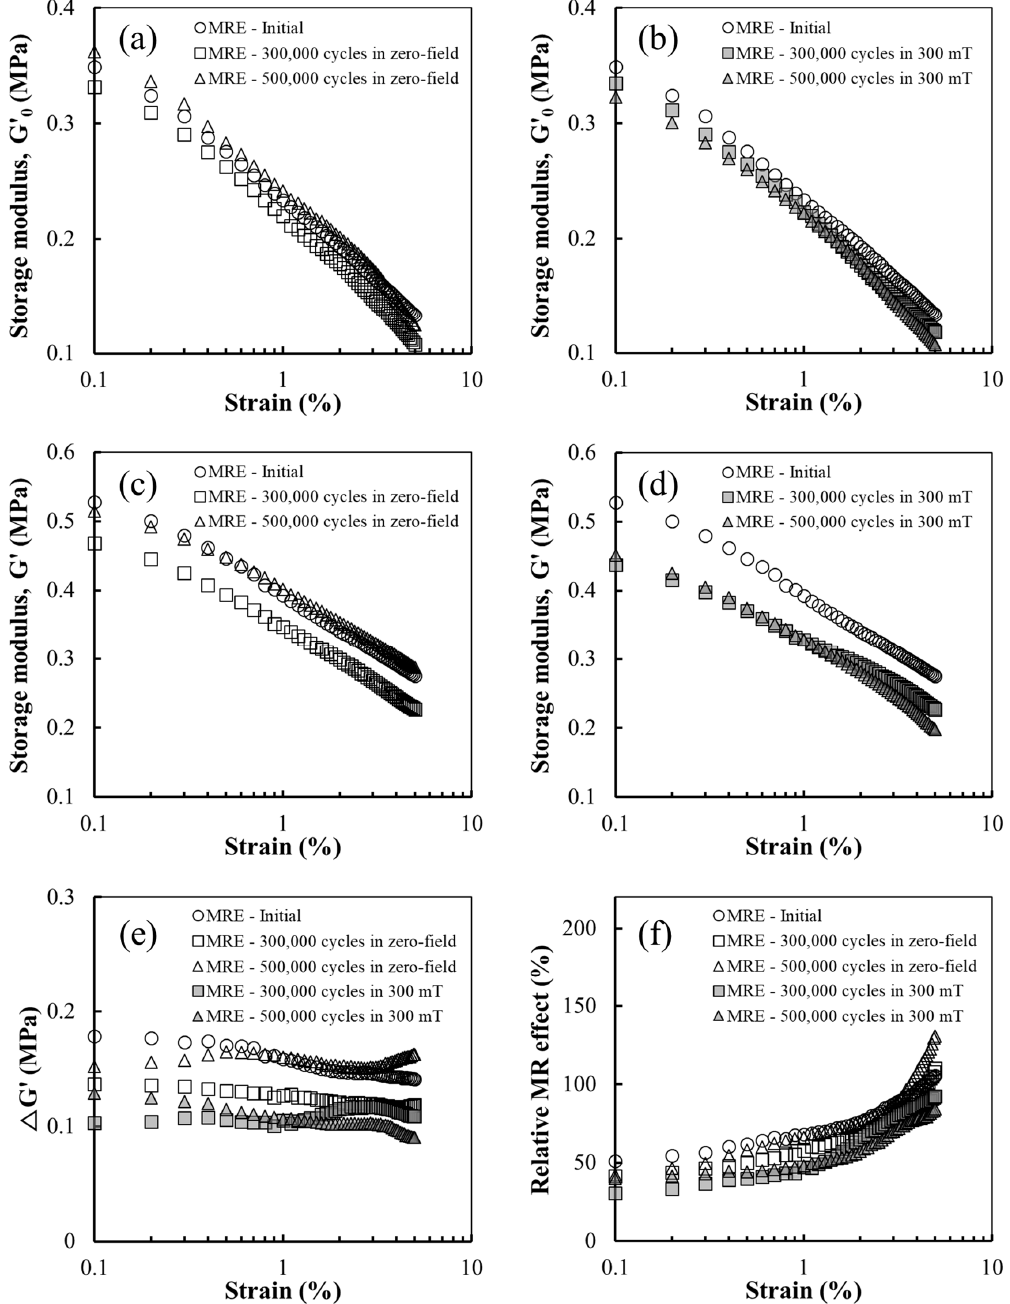
Figure 4. Off-state G ′ 0 of the MRE sample before and after being subjected to cyclic shear fatigue in the ( a ) absence and ( b ) presence of a magnetic field. On-state G ′ of the MRE sample before and after cyclic shear fatigue in the ( c ) absence and ( d ) presence of magnetic field. ( e ) Absolute and ( f ) relative MR effects of the MRE